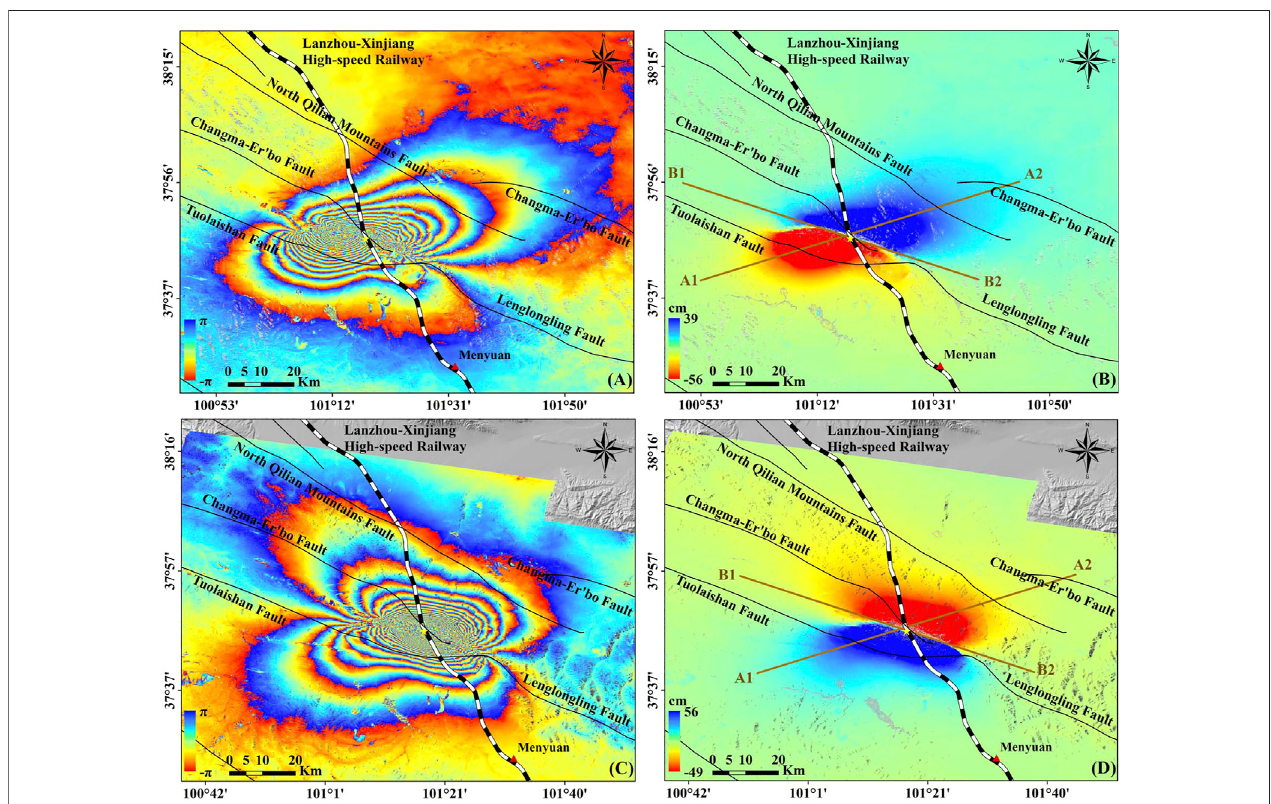
FIGURE 2 | Co-seismic interferograms and the LOS deformation fi eld of the Menyuan earthquake. (A) Interferogram and (B) LOS deformation of the ascending T128; (C) Interferogram and (D) LOS deformation of the descending T33.